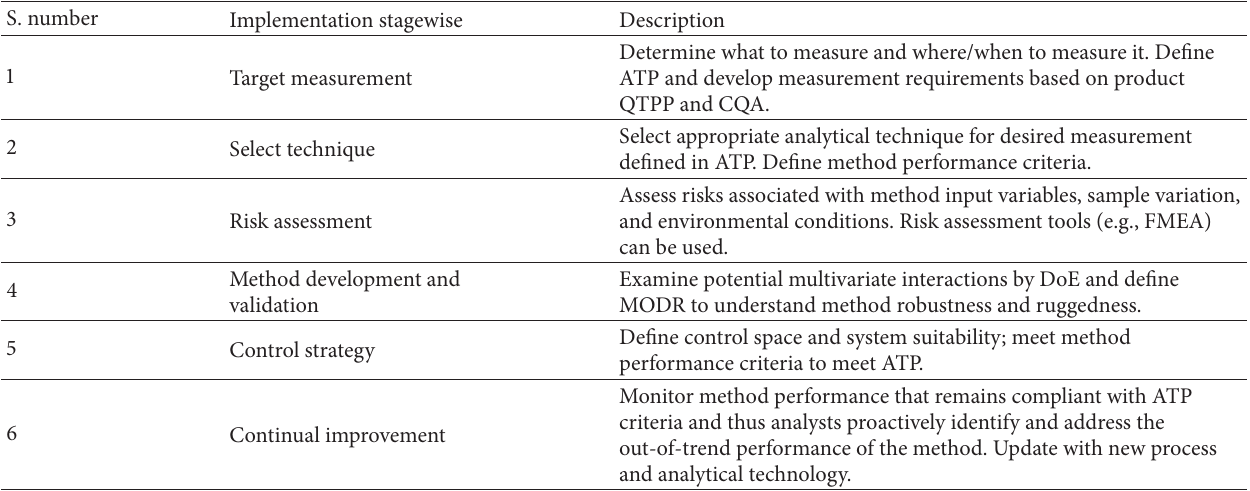
Table 3: Implementation of analytical QbD in pharmaceutical quality system.